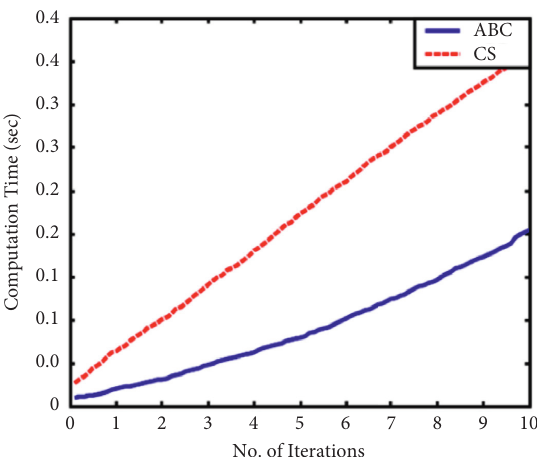
Figure 3: Convergence